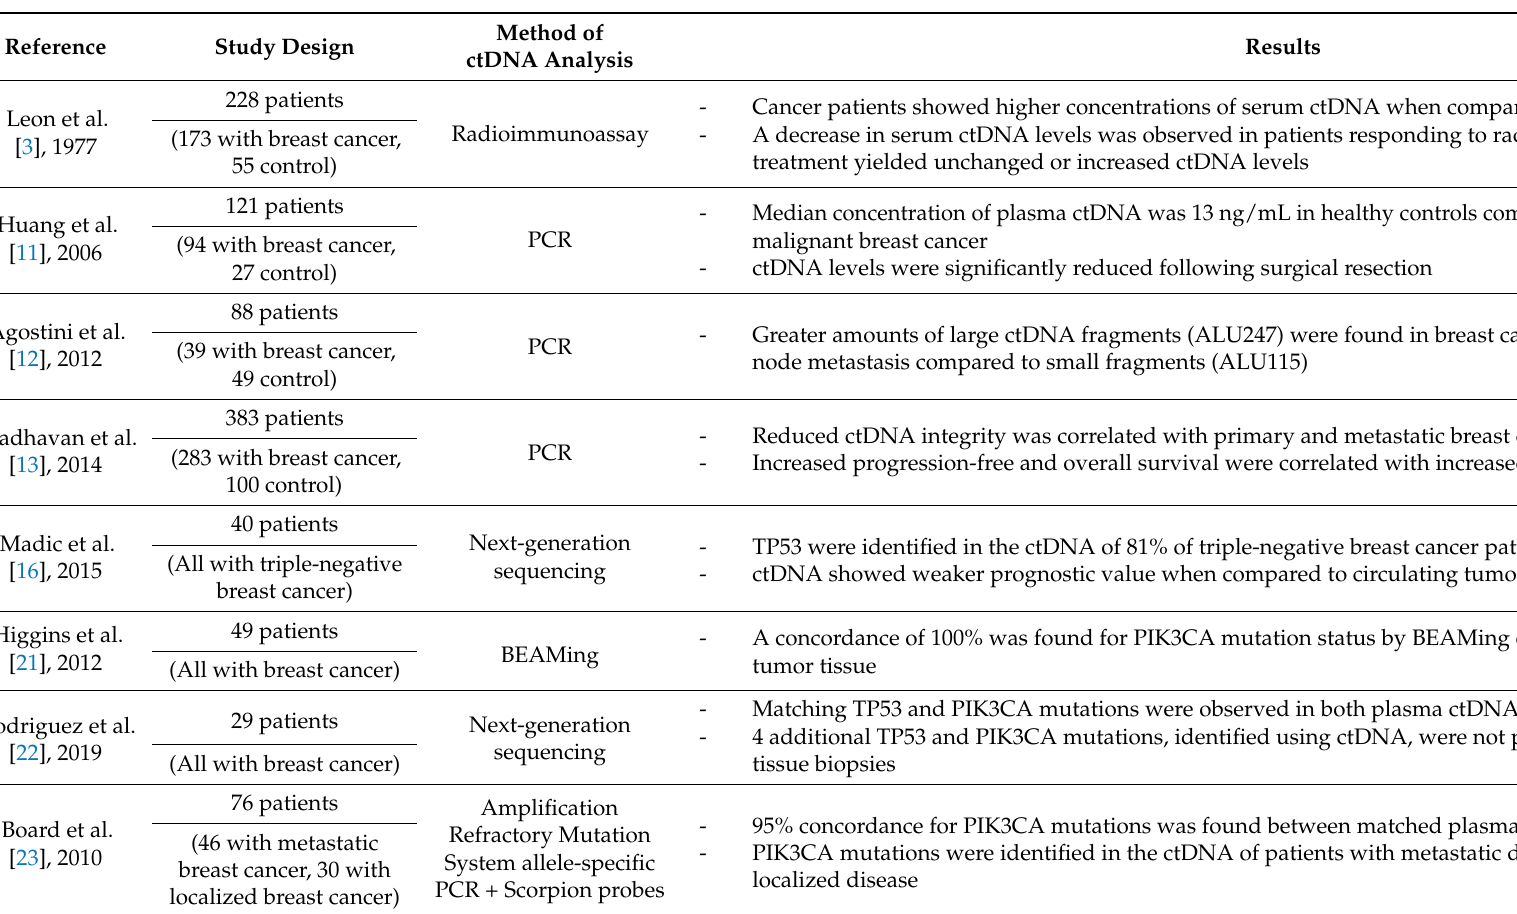
Table 1. Summary of studies exploring the use of ctDNA for the diagnosis of breast